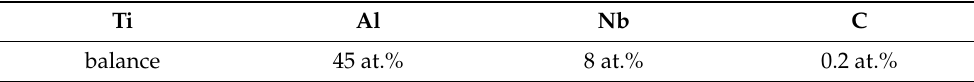
Table 1. Nominal chemical composition of the TNB-V2 alloy.